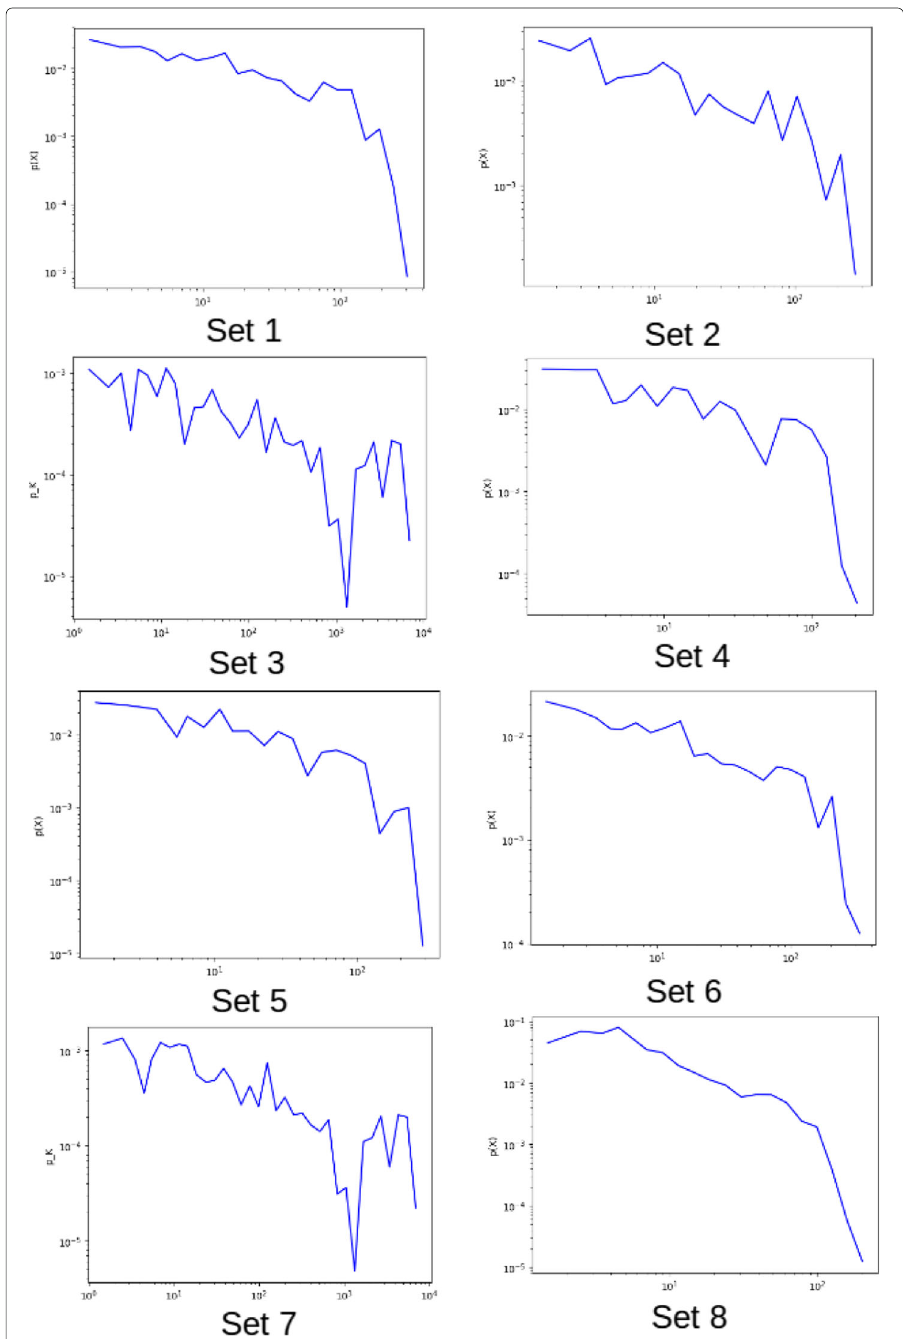
Fig. 5 Degree distributions of the Phone extraction network for the eight datasets described in Table 5, in support of the findings in ResearchQuestion2 . The X-axis and Y-axis respectively plot the degree and its empirical frequency in the network. Scales are